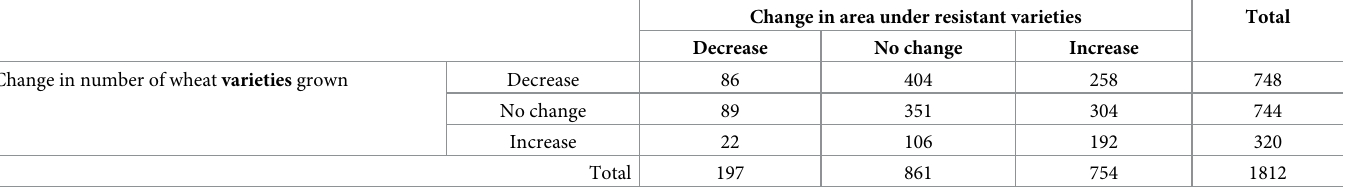
Table 4. Distribution of the sample households in their direction of adjustments in area and variety portfolio (for those who grew wheat during both survey